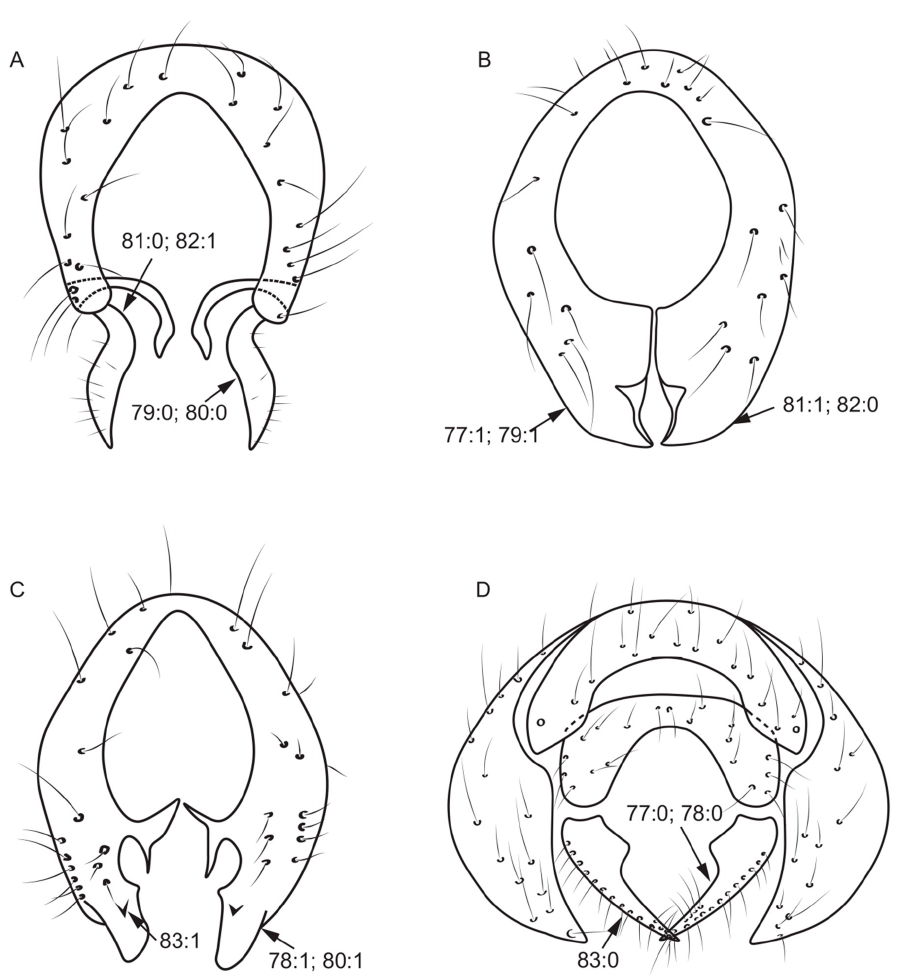
Figure 7. Epandrium characters. ( A ): Homoneura (Homoneura) trispina ; ( B ): Homoneura (Homoneura) dorsacerba ; ( C ): Homoneura (Homoneura) posterotricuspis ; ( D ): Pachycerina decemlineata . 82. Width of the middle of surstylus/length of surstylus: (0) ≥ 1/2 (Figure 7B); (1) < 1/2 (Figure 7A). 83. Fine teeth or terminal processes on surstylus: (0) absent (Figure 7D); (1) present (Fig- ure 7C). 84. Surstylus: (0) without seta; (1) with seta. 85. Shape of hypandrium: (0) U-shaped (Figure 8A); (1) Y-shaped (Figure 6D); (2) H- shaped (Figure 8D); (3) W-shaped (Figure 8B). 86. Middle of anterior margin of hypandrium: (0) without inner processes (Figure 8D); (1) with inner processes (Figure 6D). 87. Both sides anterior margin of hypandrium: (0) without inner processes; (1) with inner processes (Figure 8A). 88. Middle of posterior margin of hypandrium: (0) without ventral process (Figure 8A); (1) with ventral process (Figure 8D).